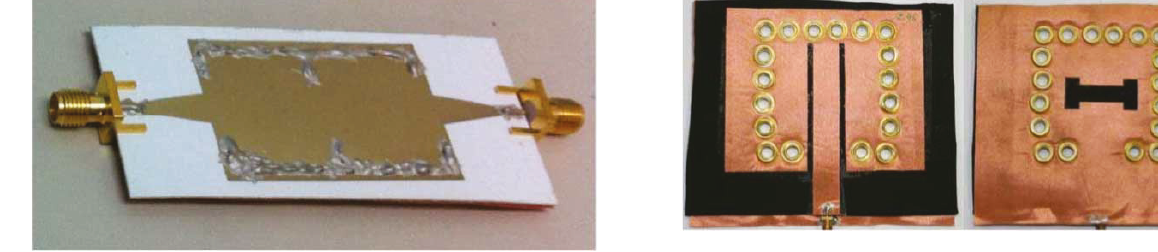
Figure 13: Implementation of a paper-based SIW fi lter [69].